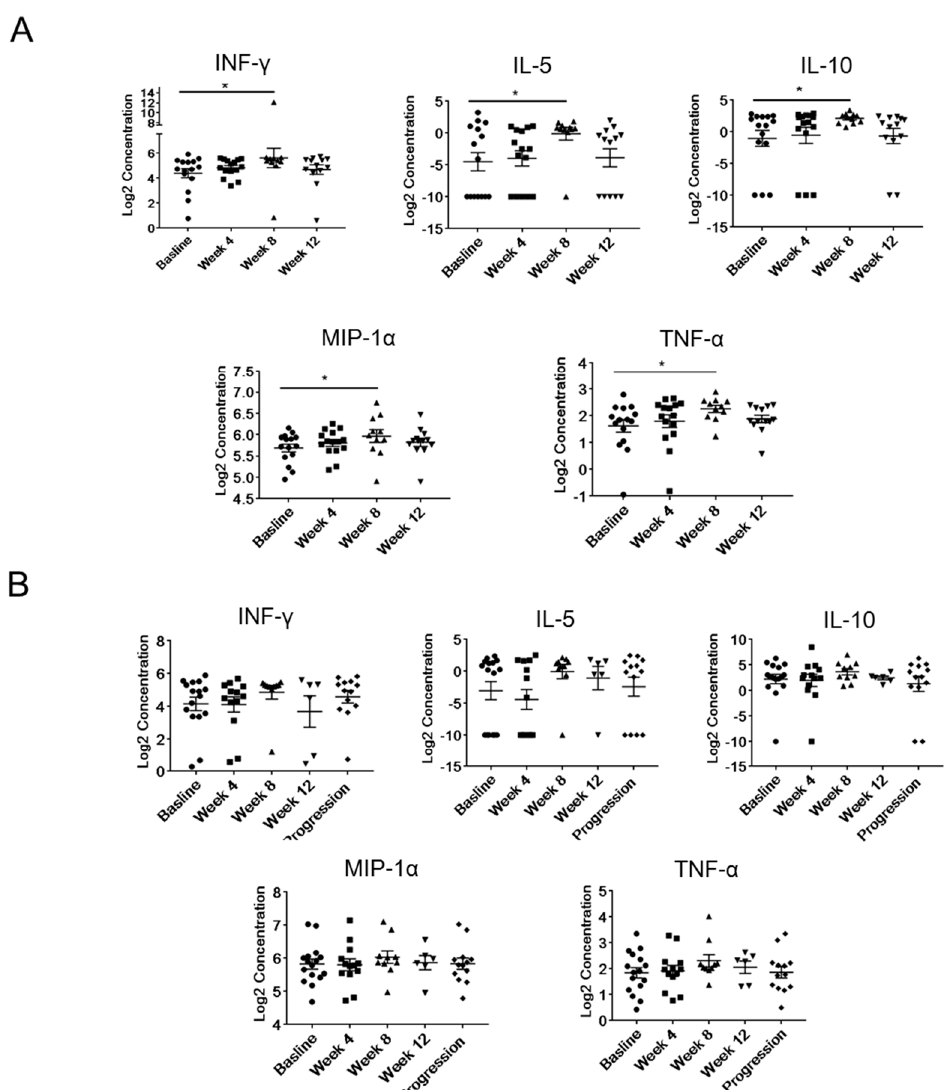
Figure 3. The longitudinal analysis of plasma levels of immune-related mediators in mCRPC patients undergoing abiraterone and / or enzalutamide treatment. Longitudinal changes of plasma level of IFN γ , IL-5, IL-10, MIP-1 α , and TNF α were measured using Luminex assay. Shown are results derived from treatment-sensitive ( A ) (Baseline, n = 15; week 4, n = 15; week 8, n = 11; week 12, n = 13) or treatment-resistant patients ( B ) (Baseline, n = 16; week 4, n = 13; week 8, n = 10; week 12, n = 6; progression, n = 13). * p < 0.05.